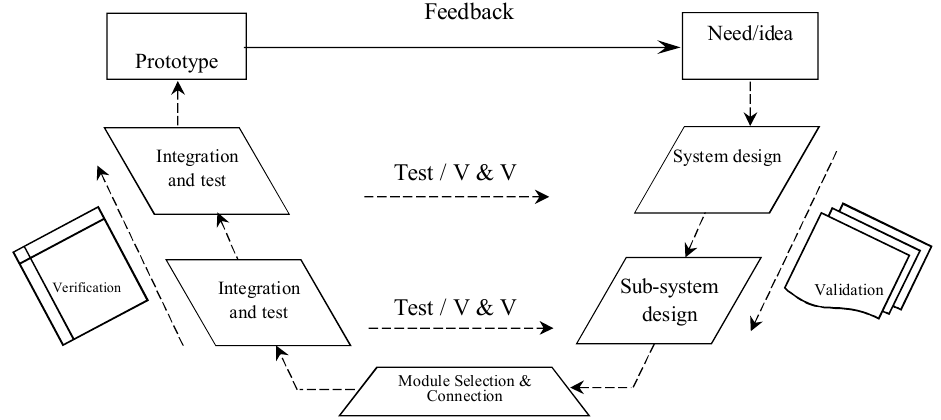
Fig 5. Repeating the loop of V-model for finalizing a product